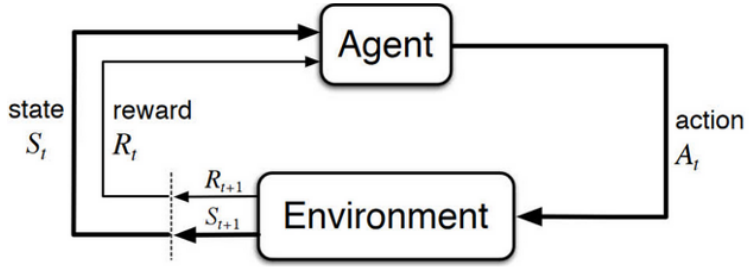
Figure 5. Markov decision